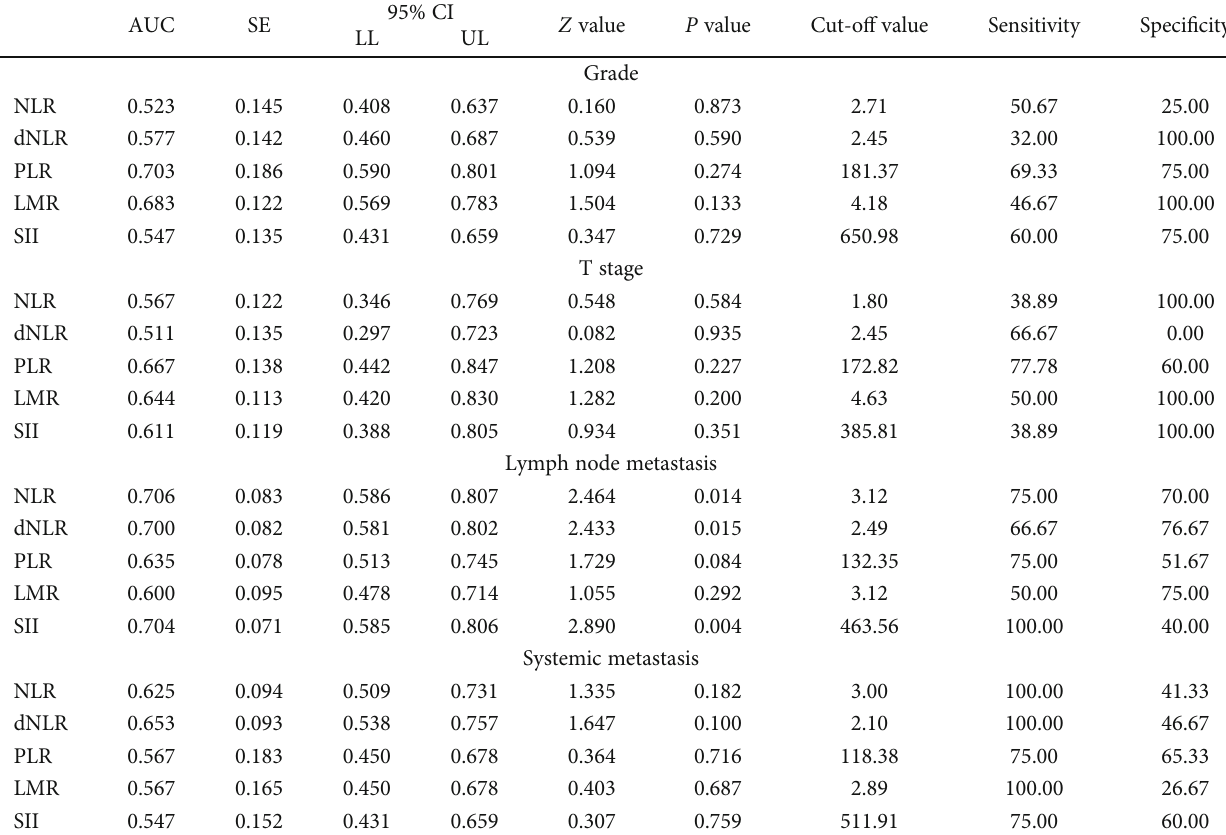
Table 2: The AUC and cut-o ff values of the IFs for